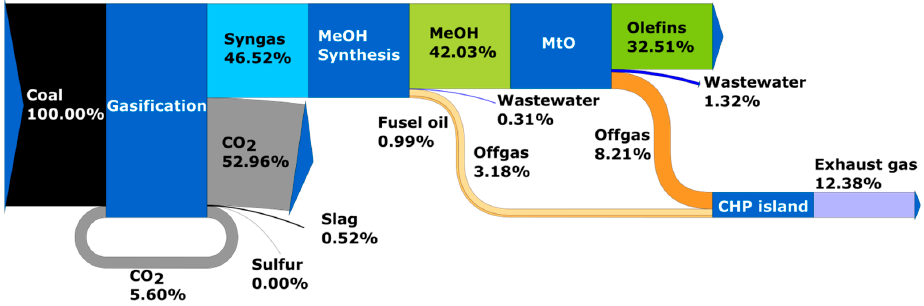
Figure 8. Carbon element distribution in olefins from hard coal production system (2030).